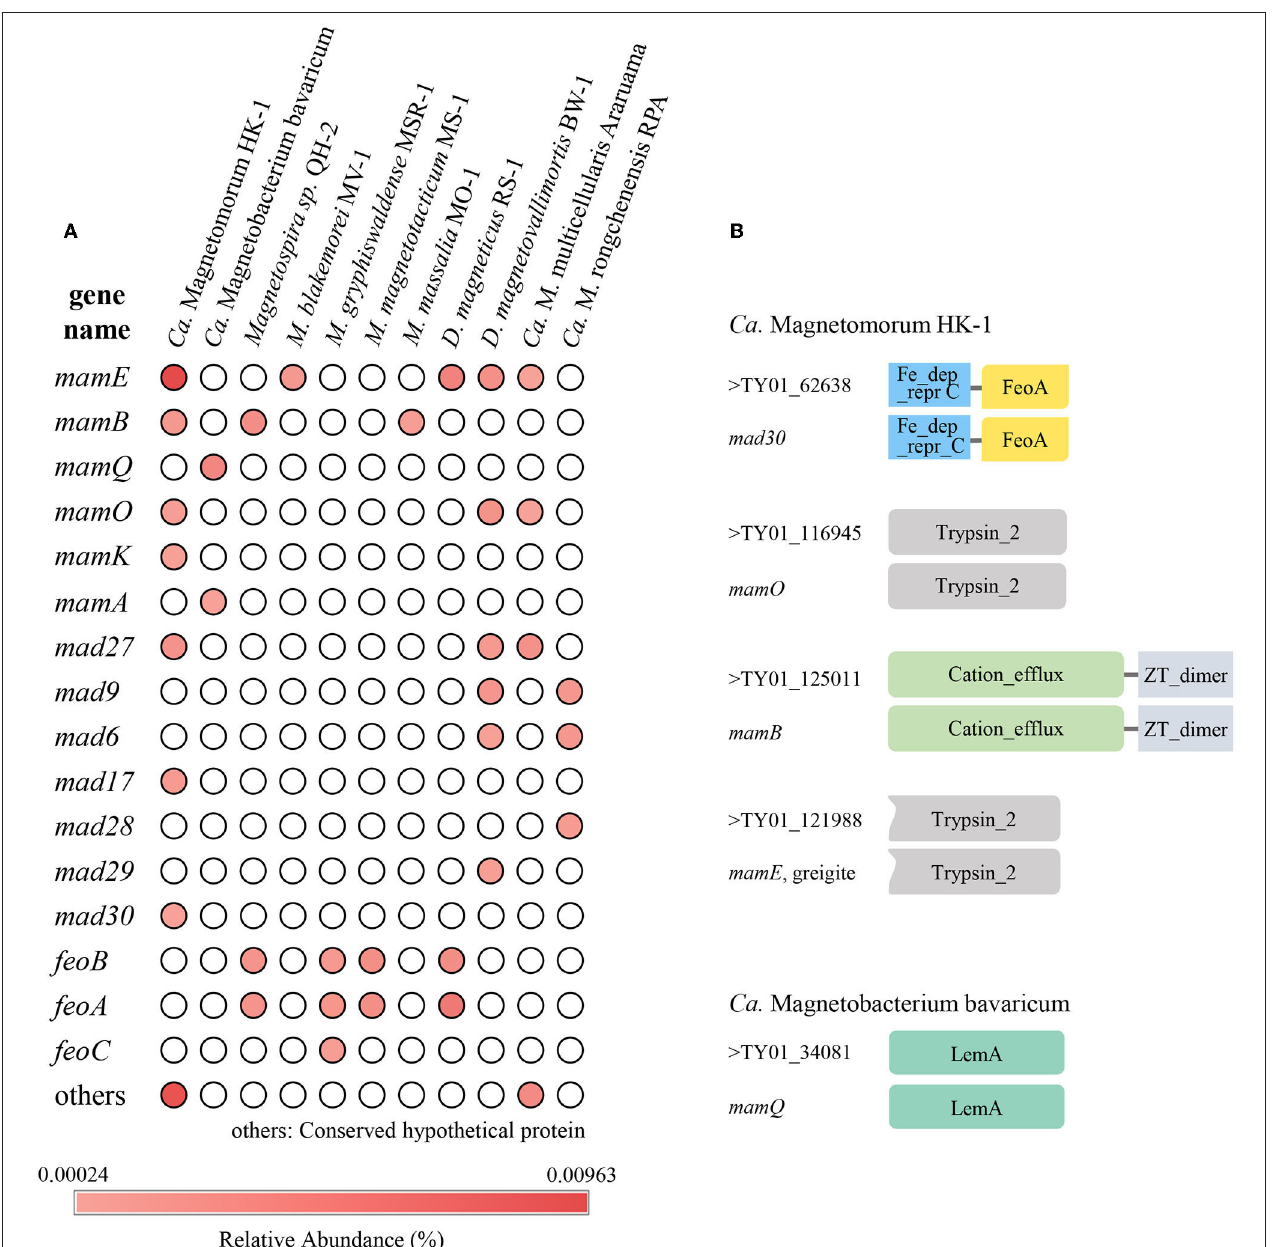
FIGURE 5 | Homologous magnetosome genes analyses. (A) Relative abundance of homologous sequences of magnetosome genes in the sampled sediment. (B) Structural domain prediction for sequences that were homologous to Ca. Magnetomorum HK-1 and Ca. Magnetobacterium bavaricum . Fe_dep_repr C, Iron dependent repressor, metal binding, and dimerization domain; FeoA, FeoA domain; Trypsin_2, trypsin-like peptidase domain; Cation_efflux, Cation efflux family; ZT_dimer, Dimerization domain of Zinc Transporter; LemA, LemA protein family domain.